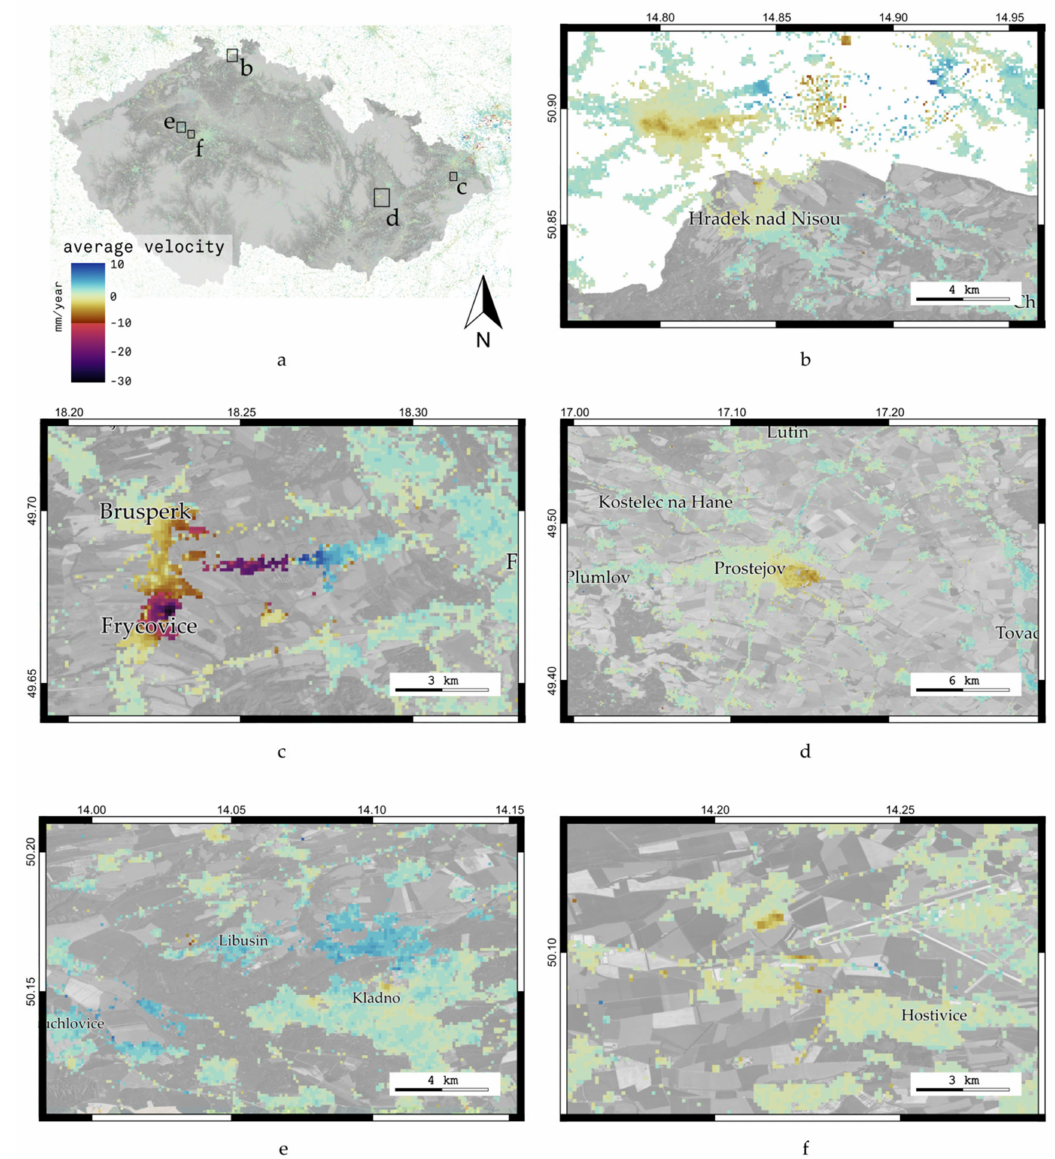
Figure 7. Examples of detected terrain deformations within the full-scale nationwide PS processing (Sentinel-1 data from October 2014–September 2017, processed by STAMPS PS through IT4S1 system): ( a ) Map overview localising zoomed-in areas in this figure, ( b ) subsidence in the surroundings of Tur ó w, ( c ) subsidence and uplift due to mining activities in the Brusperk area, ( d ) settlement in the industrial zone of Prostejov, ( e ) uplift in the surroundings of Kladno, ( f ) local subsidence near